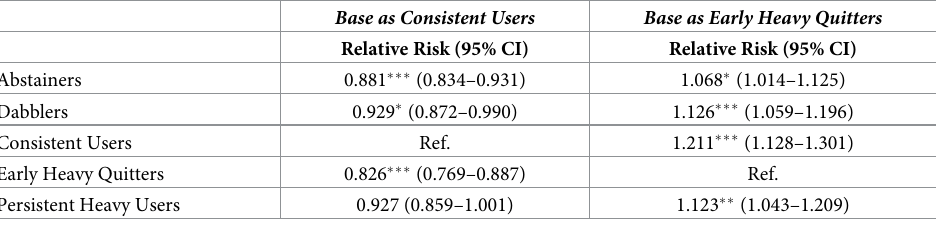
Table 5. Key comparisons for other base groups (n = 3,903).